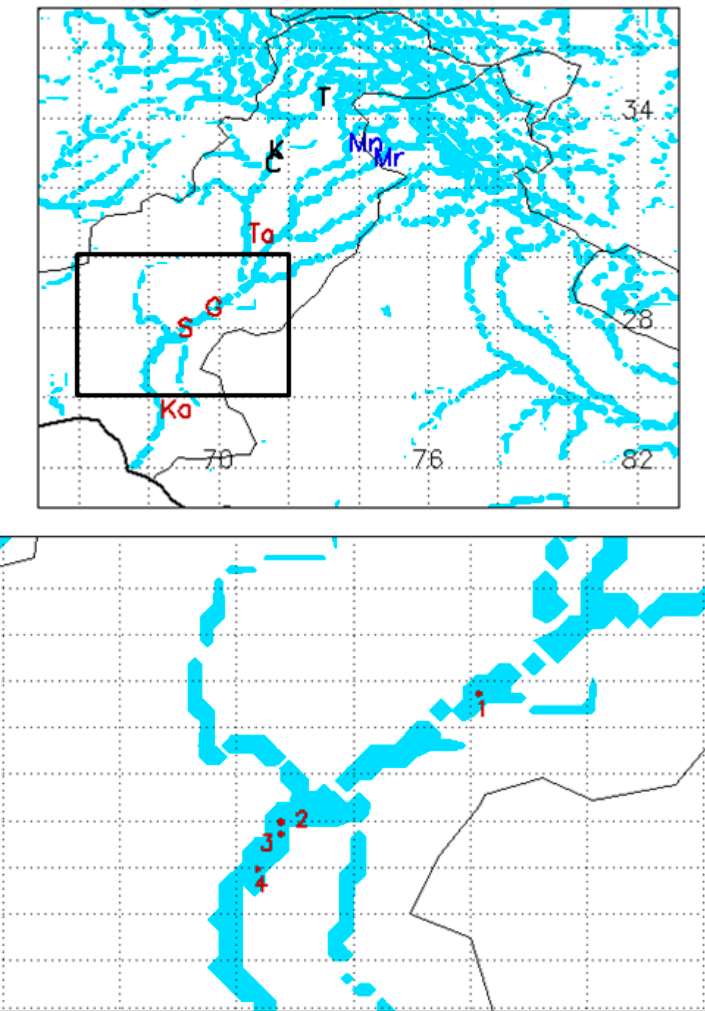
Figure 7. Location of observed streamflow from Indus and its tributaries ( Top ). Black-colored stations are from upstream locations along the Indus river, red-colored stations are from downstream locations along the Indus river, and blue-colored stations are along the tributaries of the Indus river. T = Tarbela, K = Kalabagh, C = Chasma, Mn = Mangla, Mr = Marala, Ta = Taunsa, G = Guddu, S = Sukkur, and Ko = Kotri. The location of the water height sites from altimetry is shown ( bottom ), which is the enlarged region shown in the black box in the top figure.